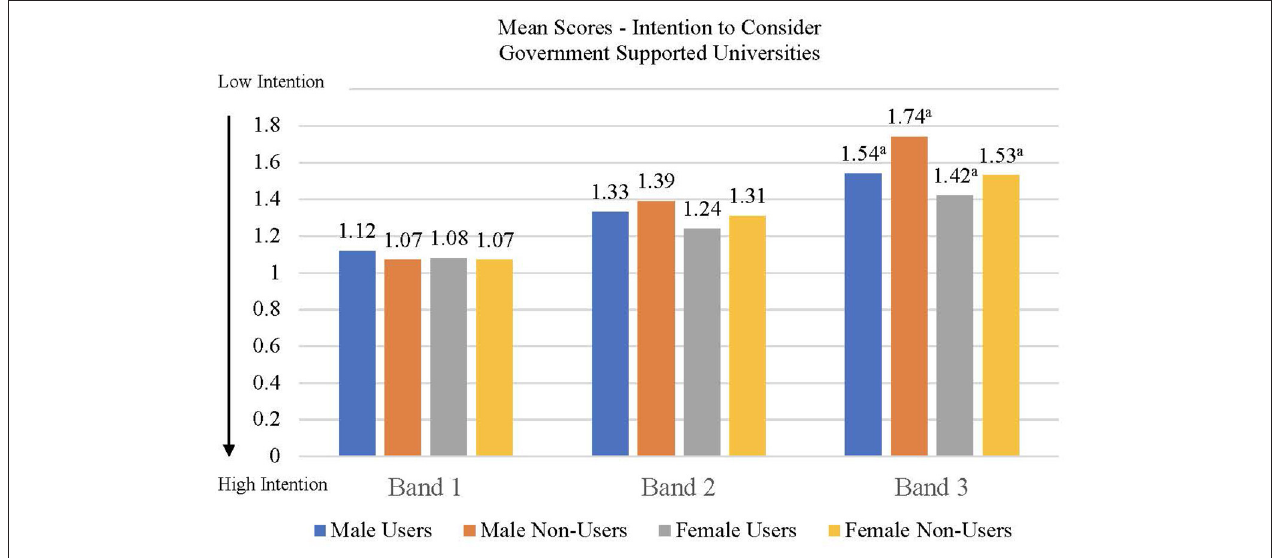
FIGURE 5 | User status × school banding interaction of the intention to consider government supported universities item. N = 2,935 12th graders (1,549 females and 1,374 males, 12 unidentified; 844 users and 2,091 non-users). Scores ranged from 1 to 3 with lower scores indicating higher intention to consider government supported universities. a Users from band 3 schools had significantly lower scores (i.e., higher intention) than non-users from the same school banding ( p <